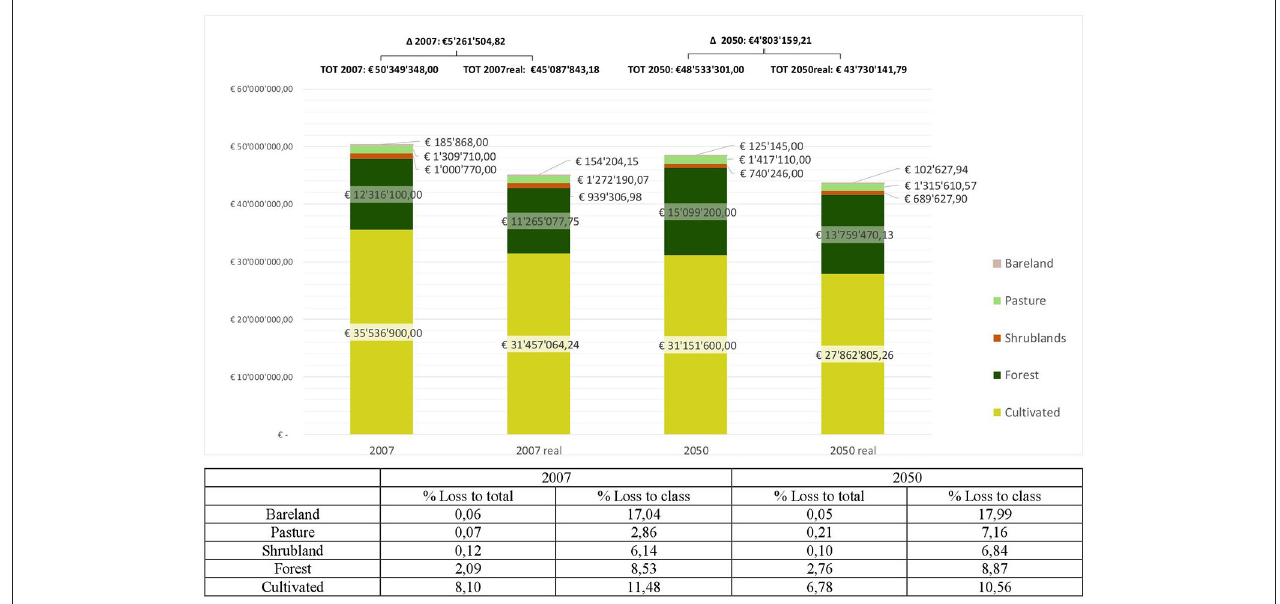
FIGURE 4 | Histogram of the Rivo land monetary values for 2007 and 2050, differentiated between the official standard values and those diminished by the interaction with landslide susceptibility (real). In the bottom table the loss percentages with respect to the total area (% Loss to the total), and to the class official value (% Loss to the class) are